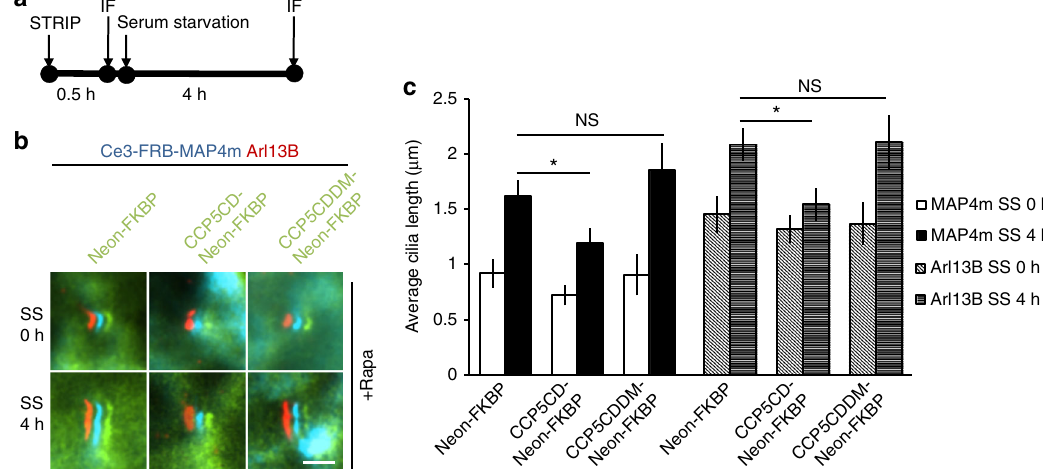
Fig. 3 Glutamylation is important for cilia elongation. a Experimental procedure for applying STRIP together with immuno fl uorescence staining (IF) in b before and after serum starvation-induced cilia elongation. Washout of rapamycin after a 30-min incubation did not affect protein dimerization in cells owing to the irreversible nature of the CID system. b , c Rapid deglutamylation inhibits serum starvation-induced cilia elongation. NIH3T3 cells were transfected with P2A-based constructs for co-expression of Cerulean3 – FRB – MAP4m and Neon-FKBP-tagged proteins. Transfected cells at 80 – 90% con fl uency were incubated with 100 nM rapamycin for 30 min and then serum-starved for the indicated times. The length of the axoneme and of cilia was quanti fi ed in cells expressing the indicated proteins with rapamycin treatment before and after serum starvation (SS) for 4 h. The images show shifted overlays of the indicated proteins in cilia. Scale bar, 2 μ m. c Average length of cilia labeled by MAP4m and Arl13B in b . Data represent the mean ± s.e.m. ( n = 83, 80, 58, 59, 102, 92, 65, 82, 52, 51, 53, and 51 cells from left to right; three independent experiments). NS and * indicate no signi fi cant difference and P < 0.05, respectively, between the control (Neon-FKBP) and the indicated groups (Student's t